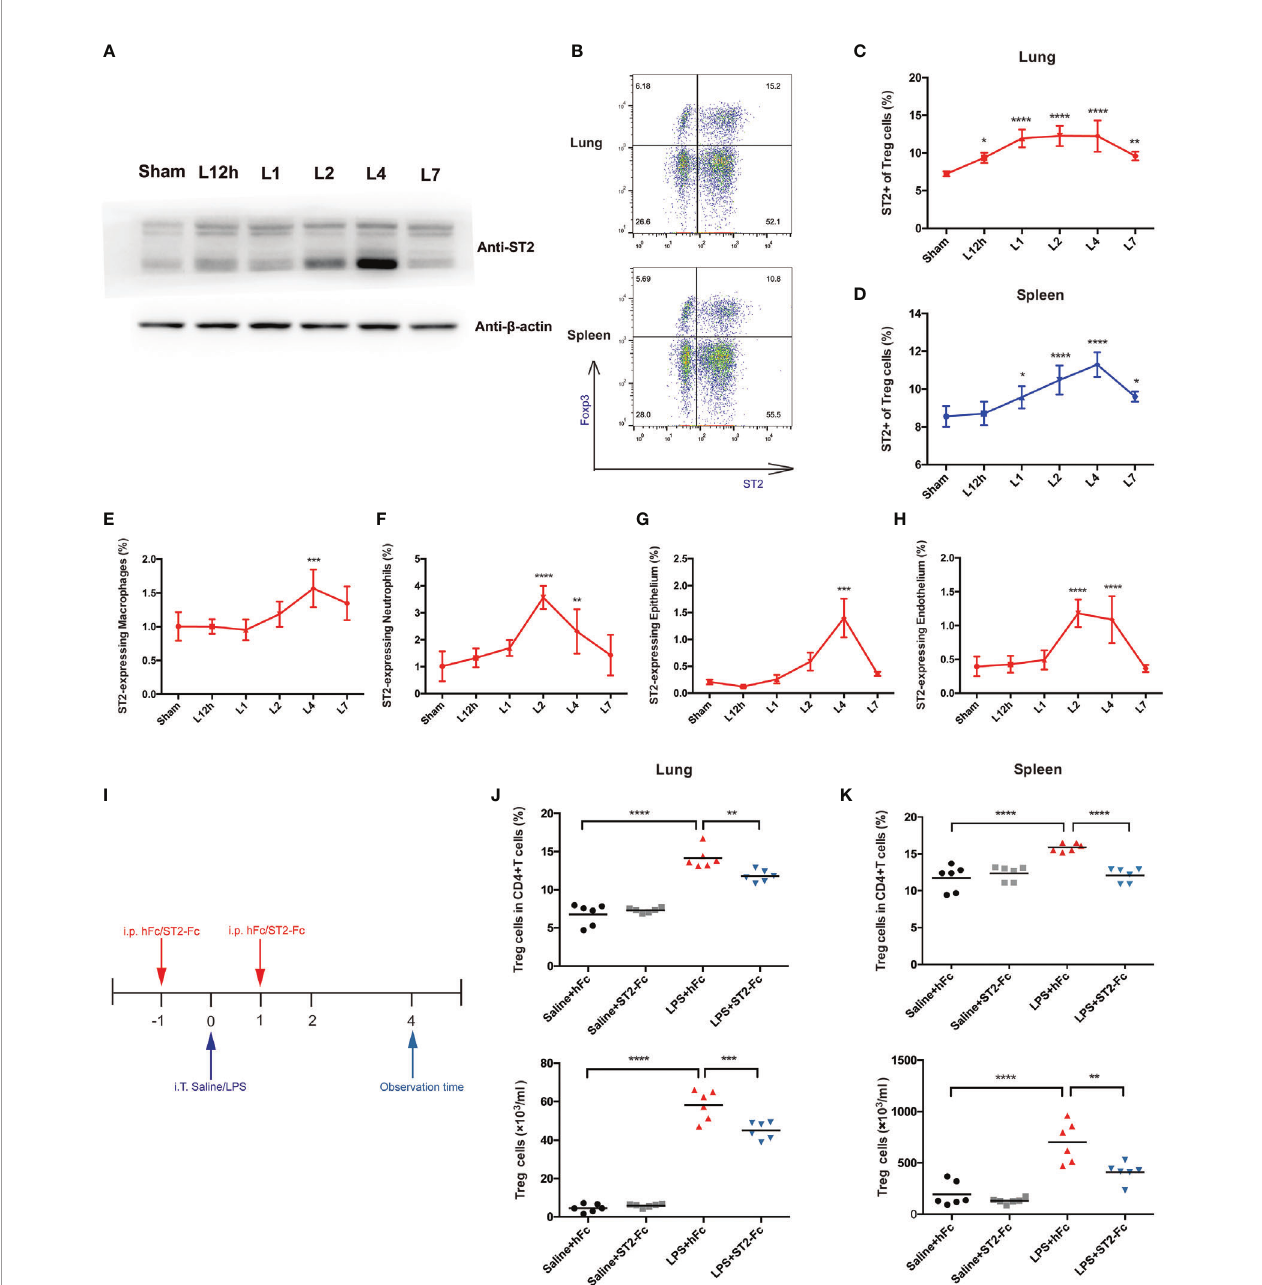
FIGURE 5 | Involvement of the IL-33:ST2 axis in pulmonary Treg cell accumulation. (A) A late spike in ST2 expression. BALB/c mice were intratracheally injected with LPS, and at various times, the ST2 protein was detected by Western blotting. The sham group was intratracheally administered saline. (B – D) Flow cytometric analysis. Lungs and spleens from mice were prepared at different time points after LPS administration. (B) Dot plots of ST2+ Treg in fl ow cytometry. (C) Summary data for the fraction of ST2+ Treg cells in the lung and (D) the fraction of ST2+ Treg cells in the spleen within days after LPS administration. (E, F) Summary data for the ST2 fraction within different leukocyte populations at various times after LPS administration. (E) Fraction of ST2+ macrophages. (F) Fraction of ST2+ neutrophils. (G, H) Summary data for the ST2 fraction within the epithelium or endothelium at various times after LPS administration. (G) Fraction of ST2+ epithelial cells and (H) fraction of ST2+ endothelial cells. (I) Schematic diagram of the protocol used to establish ST2-blocked mice. BALB/c mice were injected with hFc/ST2-Fc, and 1 day later, intratracheal administration of saline/LPS and hFc/ST2-Fc was performed, with repeated i.p. injection after 1 day. The mice were sacri fi ced and observed at 4 days after LPS/saline. (J, K) Fraction and numbers of Treg cells by fl ow cytometric analysis, as shown in I, and the observation time was at day 4. (J) Treg cells in the lungs. (K) Treg cells in the spleen. For all panels: mean ± S.D. *p ≤ 0.05; **p ≤ 0.01; ***p ≤ 0.001; and ****p ≤ 0.0001 for one-way analysis of variance with the Bonferroni post hoc test for multiple t-tests. A value of p < 0.05 was considered statistically signi fi cant. n = 6 – 8 mice per